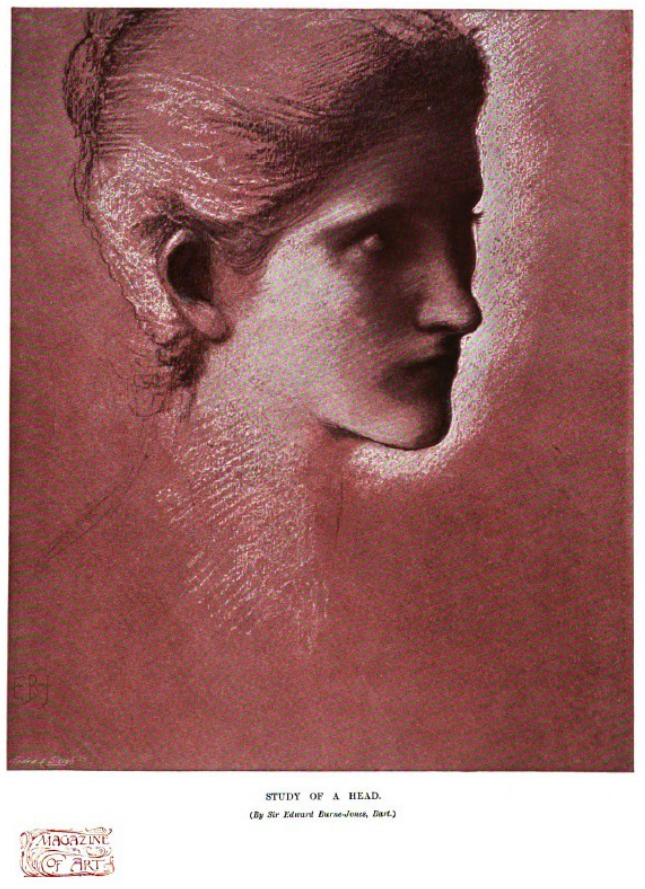
Figure 4. Edward Burne-Jones, Sketch , The Magazine of Art , v. 20–21 (1896–97), insert between pp. 50 and 51.